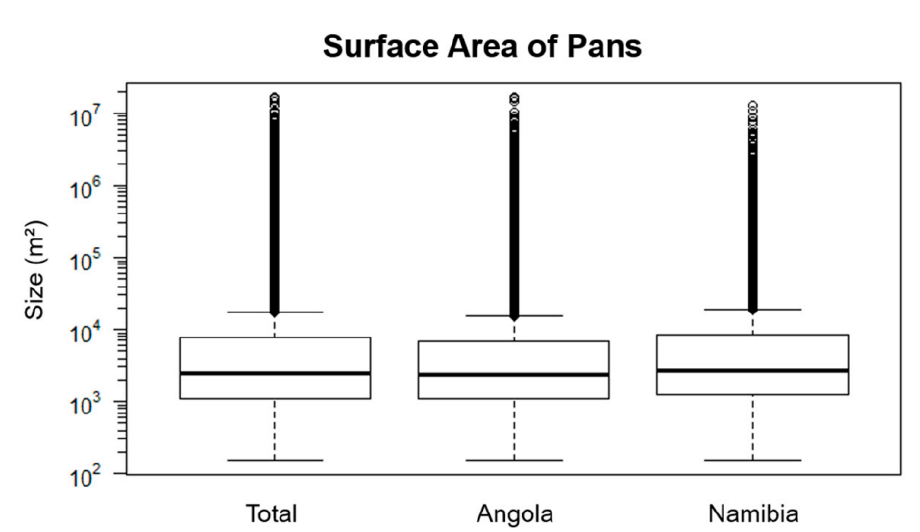
Figure 8. Surface area of pans in total, for Angola, and for Namibia, indicating the enormous number of